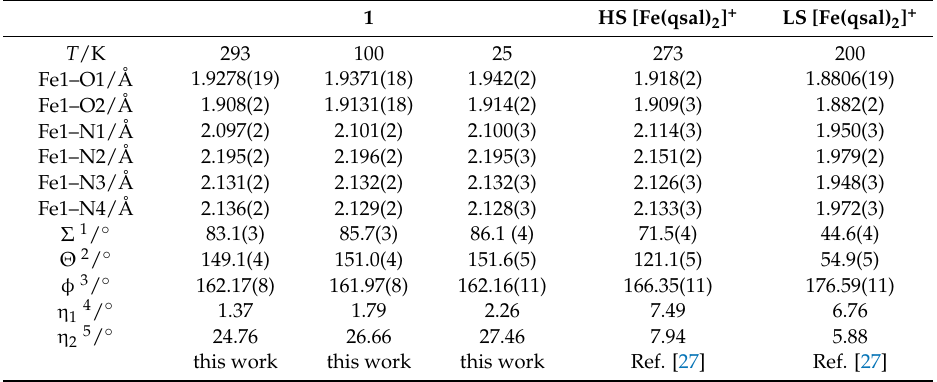
Table 2. Selected coordination bond lengths and distortion parameters of the [Fe(qsal) 2 ] molecule. 1 HS [Fe(qsal) 2 ] + LS [Fe(qsal) 2 ] + T /K